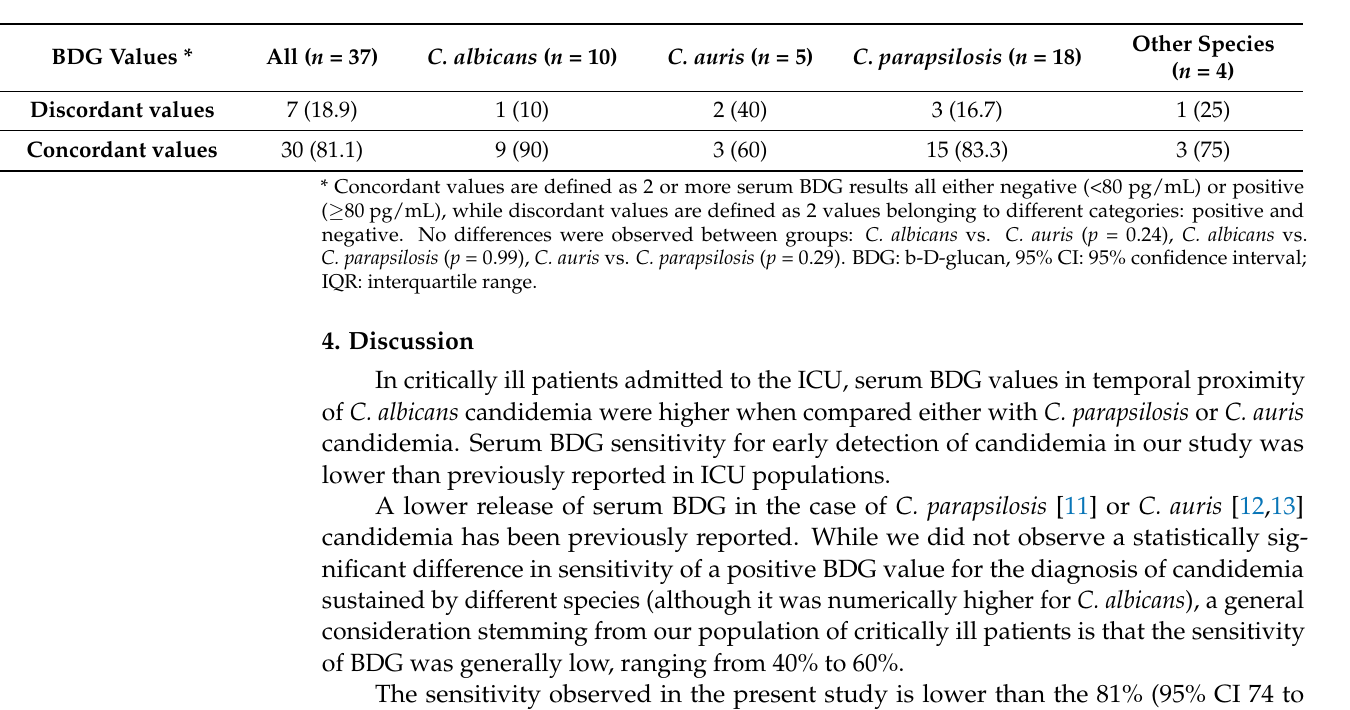
Table 2. Description of serum BDG concordance/discordance in 37 candidemia episodes with ≥ 2 BDG results